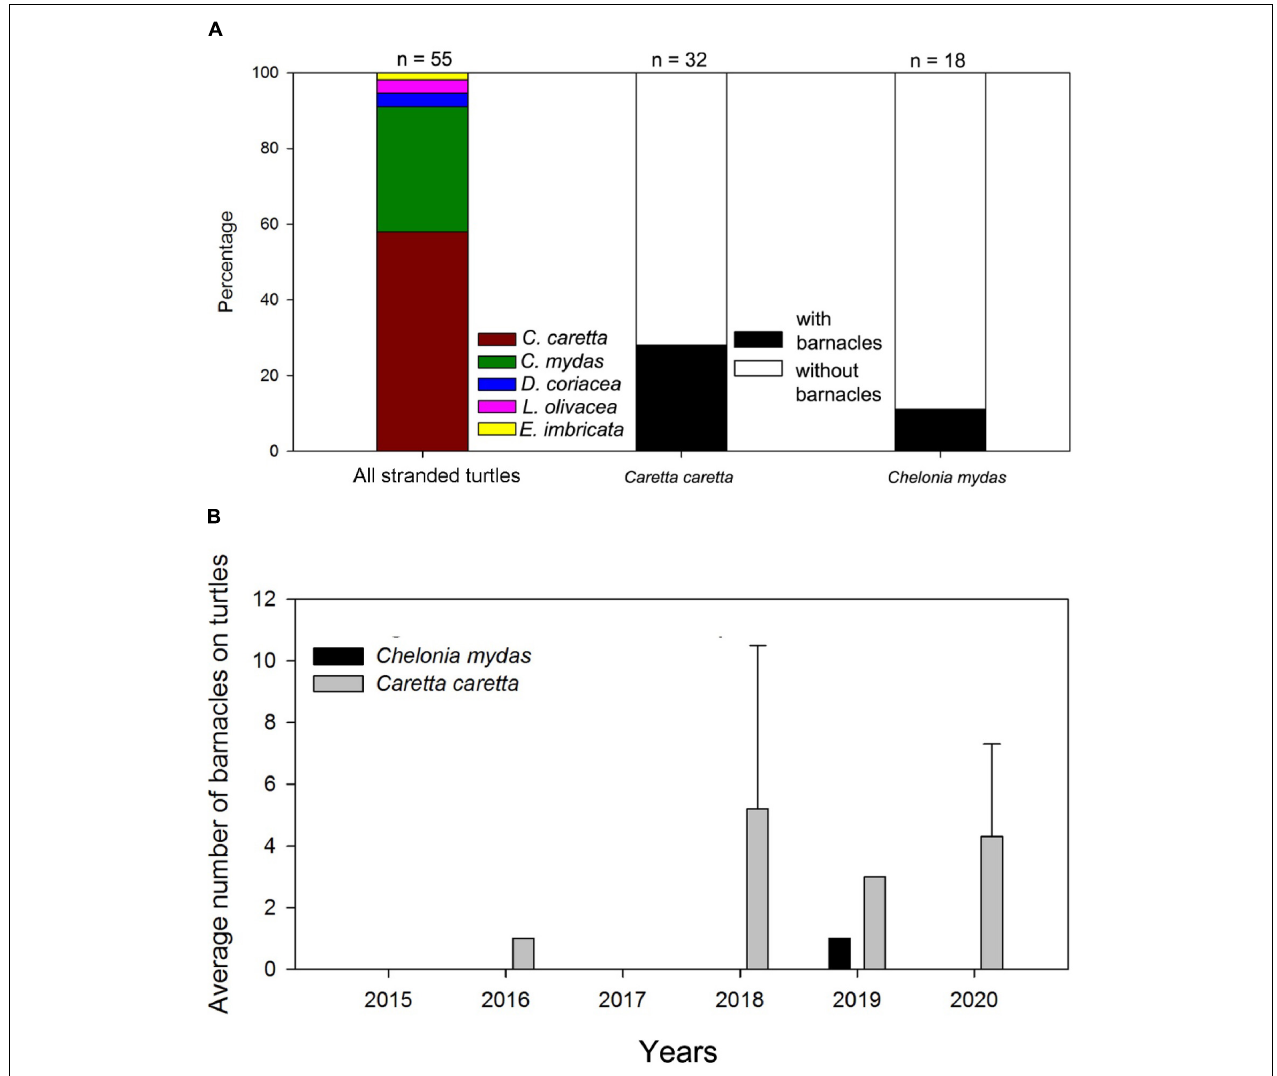
FIGURE 2 | Stranded sea turtles collected from 2015 to 2020 in Korea. (A) Percentage of stranded turtles collected from 2015 to 2020 and percentage of loggerhead and green sea turtles with barnacles; (B) Density (average number of barnacles per turtle) on stranded loggerhead and green sea turtles from 2015